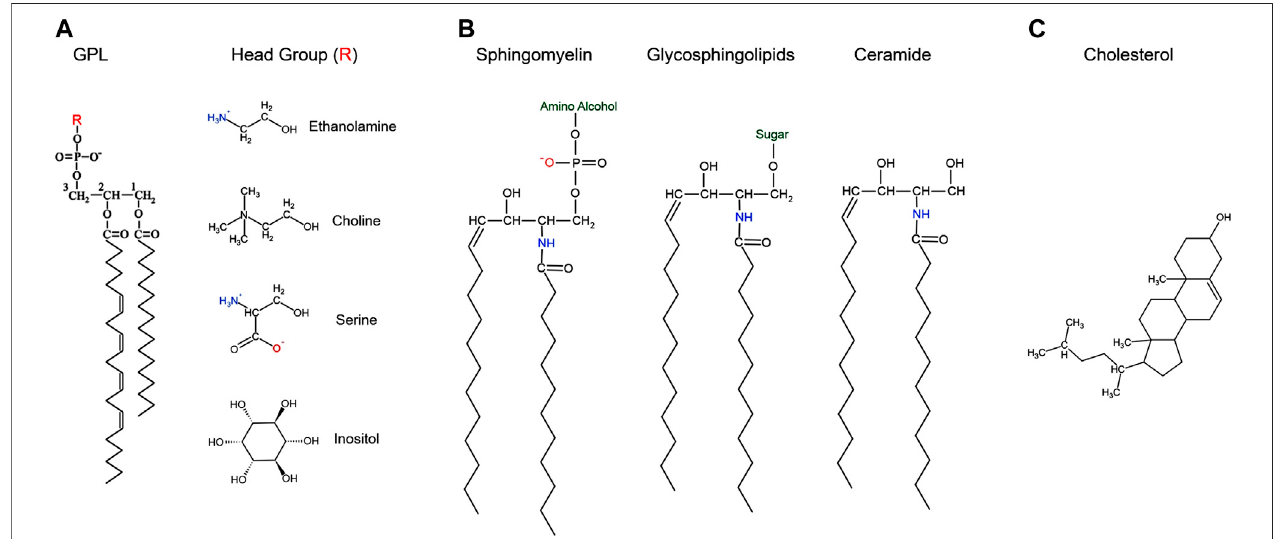
FIGURE 1 | Structure of the major classes of cellular